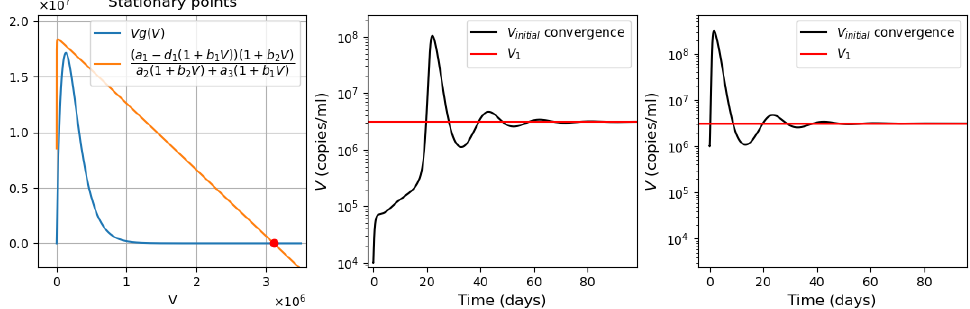
Figure 2. Left : graphical solution of Equation (9) in the monostable case with a large stationary value. Convergence to single large stationary point. Middle : initial viral load = 10 4 . Right : initial viral load = 10 6 . Interferon secretion rate g 0 = 350.